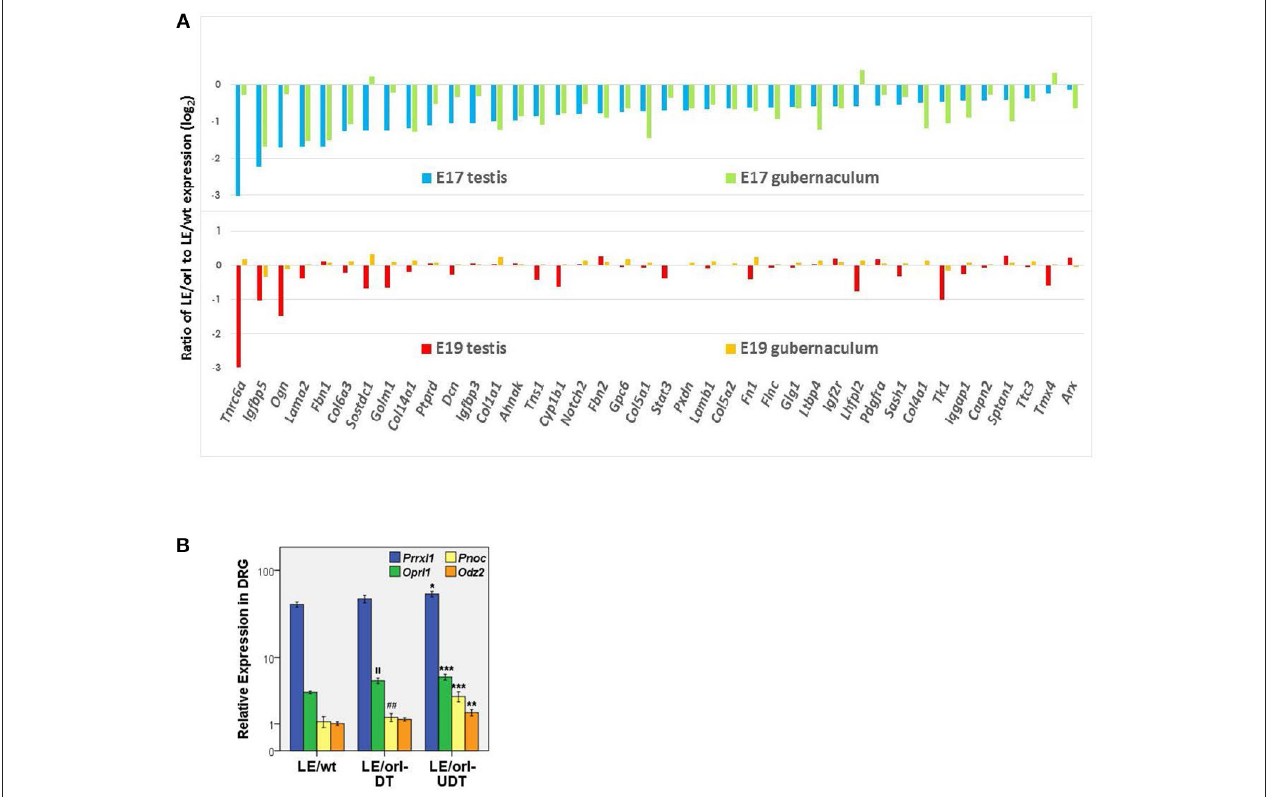
FIGURE 1 | (A) Of 315 differentially expressed genes in LE/orl testis (45), 62 (20%) are Leydig cell progenitor-specific (46) and expression was reduced in 59 (95%) of these at E17. Forty of 62 (shown here) are also differentially expressed in LE/orl gubernaculum, and 37 of these (92%) are also downregulated. By E19, coordinate expression of these genes in these tissues is lost. (B) Expression levels of the sensory transcripts Prrxl1 (paired related homeobox protein-like 1, also known as Drg11 or Drgx ), Pnoc (prepronociceptin) and its receptor, Oprl1 (opioid receptor-like 1), and Odz2 (odd oz/ten-m homolog 2, also known as Tenm2 ) measured by qRT-PCR (logarithmic mean ± SEM) in LE/wt and LE/orl L1-L2 dorsal root ganglia (DRG) ipsilateral to descended (DT) or undescended (UDT) testes. *** p < 0.001, ** p < 0.01, * p < 0.05 vs. LE/wt; || p < 0.01 vs. LE/wt; ## p < 0.01 vs. LE/orl-UDT by ANOVA; n = 5–10 per group, postnatal day 3 DRGs.